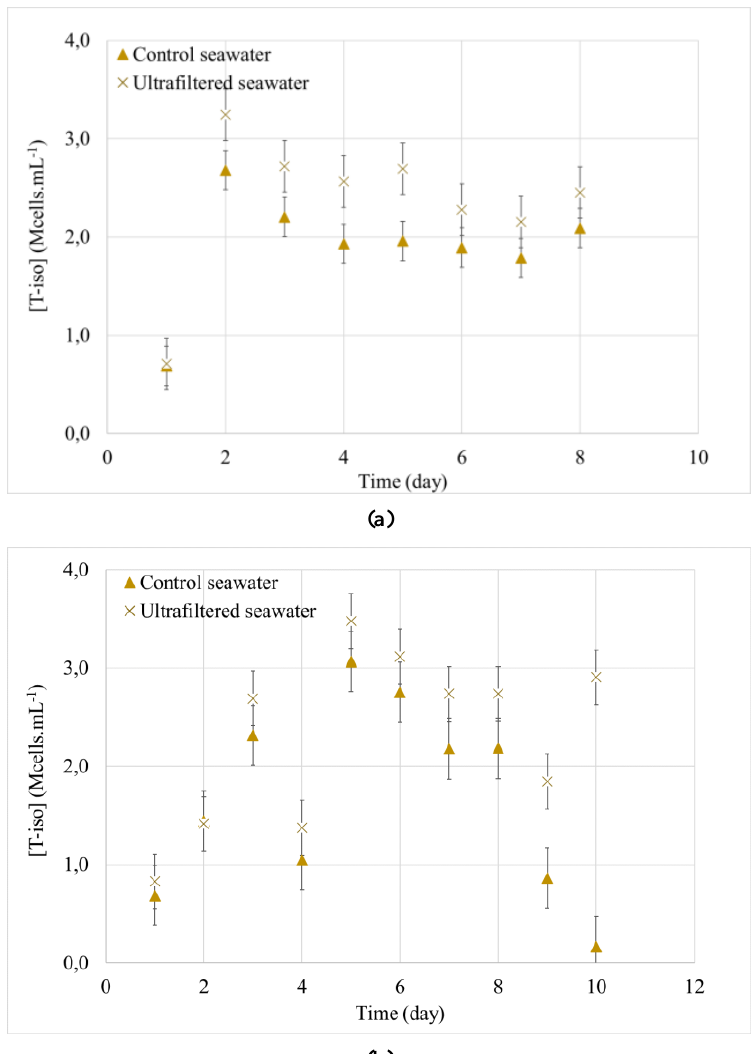
Figure 3. Monitoring of T-Isochrysis